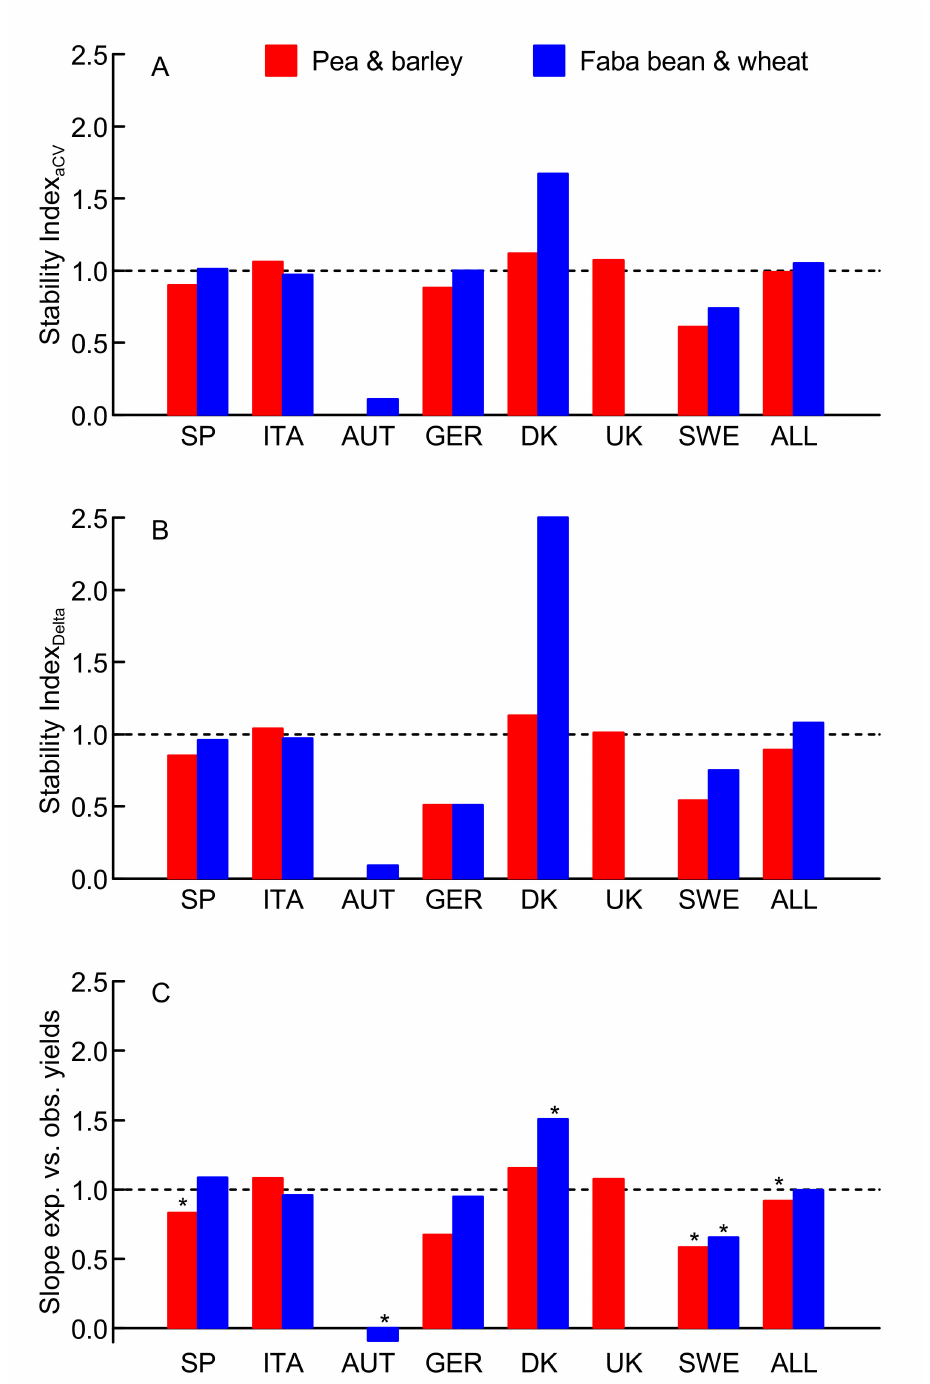
Figure 1. Crop stand-based yield stability indices calculated on basis of adjusted coefficients of variance ( A ), the yield difference (Delta) between the two cultivation years 2017 and 2018 ( B ), and the slopes for the linear regressions of expected vs. observed yields ( C ), across various barley-pea and wheat-faba bean trials cultivated in seven sites across Europe. SP Spain, ITA Italy, AUT Austria, GER Germany, DK Denmark, UK United Kingdom, SWE Sweden, ALL calculations across all sites. Asterisks indicate significant ( t -test of slopes, 95% CI, p ≤ 0.050) differences from slope = 1, based on the log e transformed yield data. For barley-pea: n = 4 (ITA), 8 (SP, GER), 20 (DK), 24 (SWE), 32 (UK) or 96 (ALL). For wheat-faba bean: n = 4 (SP, AUT), 8 (ITA), 12 (GER), 14 (UCPH), 24 (SWE) or 66 (ALL). The indices are based on ratios of mean aCV or mean yield differences, and no standard errors can be associated with the ratios and slopes presented